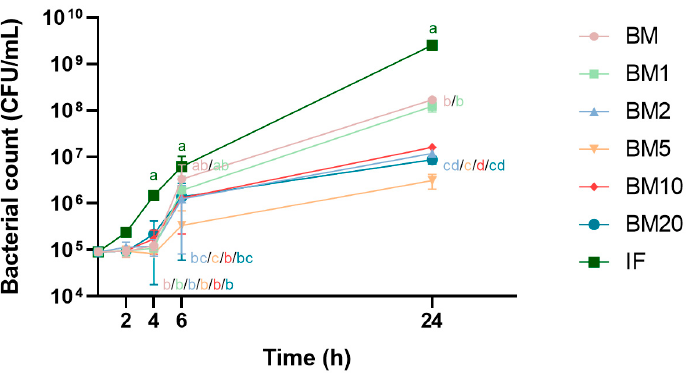
Figure 2. Growth curves of S. epidermidis, inoculated at a dose of 10 5 after incubation with infant formula (IF) or unpasteurized skimmed bovine milk (BM) with differently added concentrations of bovine milk osteopontin (BM1, 1.6 g OPN/L; BM2, 2.6 g OPN/L; BM5, 5 g OPN/L; BM10, 10 g OPN/L; BM20, 20 g OPN/L). Values are expressed as mean ± SD ( n = 3). Each incubation time point not sharing the same letters are significantly different ( p < 0.05).